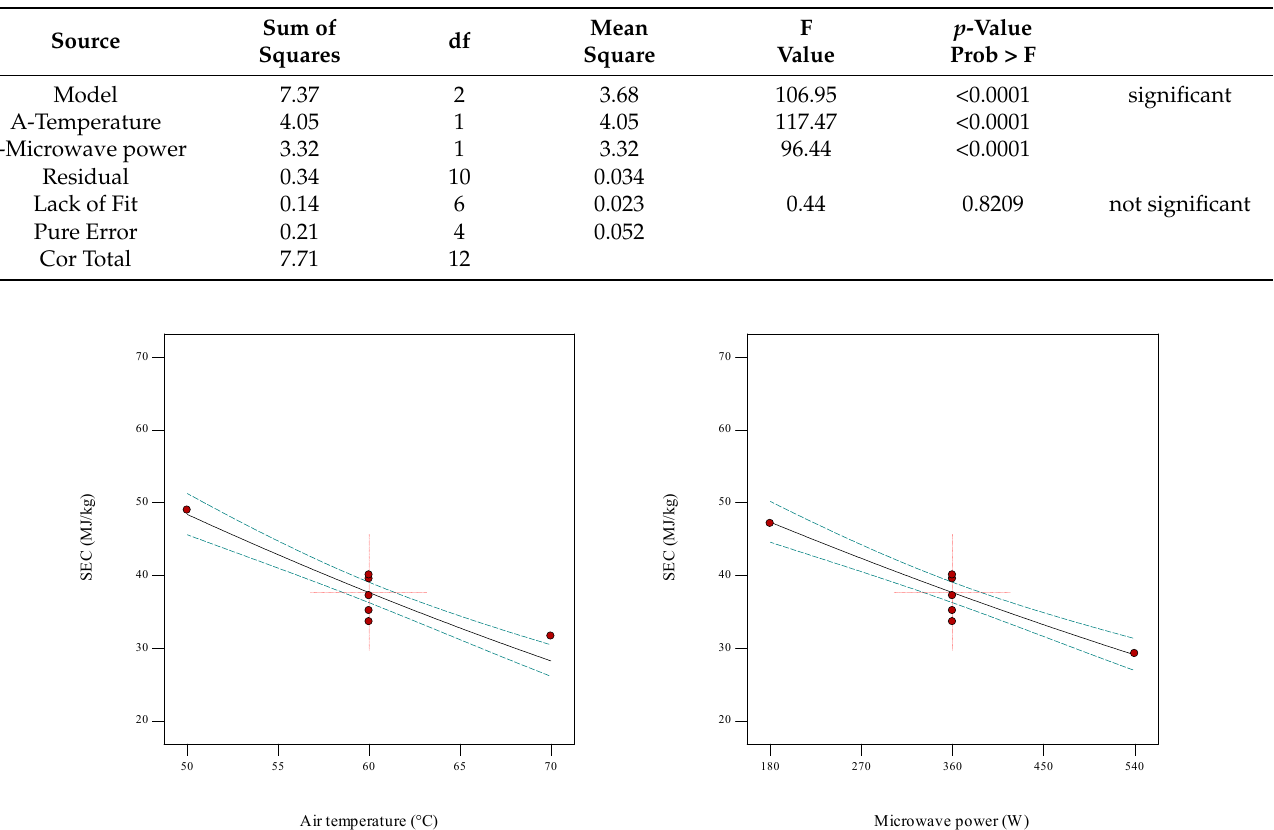
Figure 3. The effect of air temperature and microwave power alone on SEC.